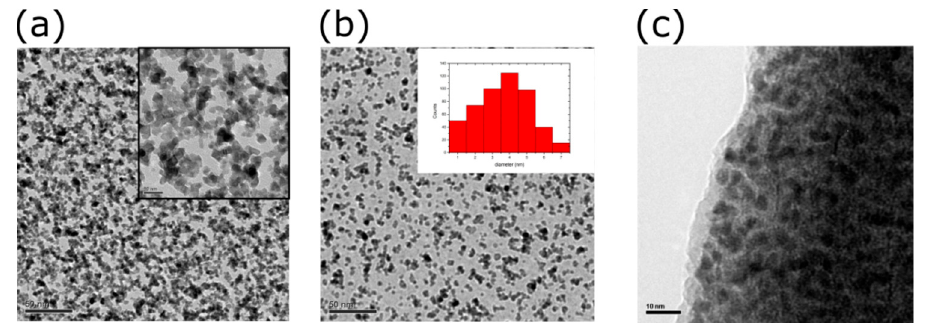
Figure 2. ( a ) TEM images of solvent-free Pt NPs with 50% surface coverage. Inset: higher magnification ( b ) TEM image of solvent-free Pt NPs with 28% surface coverage. Inset: Pt NPs size distribution ( c ) TEM image of Pt NPs covered with 5.5 nm thick alumina.